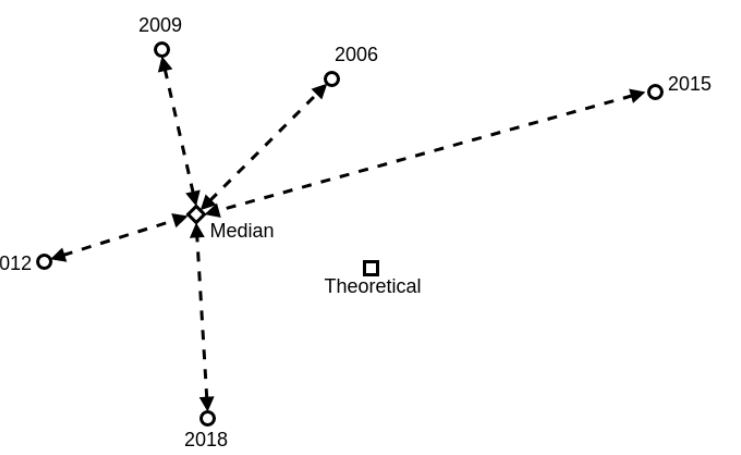
Figure 2. Space–time aggregation of observed LUCAS GPS locations (circle symbol) using the geometrical median (diamond symbol). The theoretical location snapped to a LUCAS 2 × 2 km 2 grid is represented by a rectangle symbol. The distances between the GPS and median locations are shown by arrowed dashed